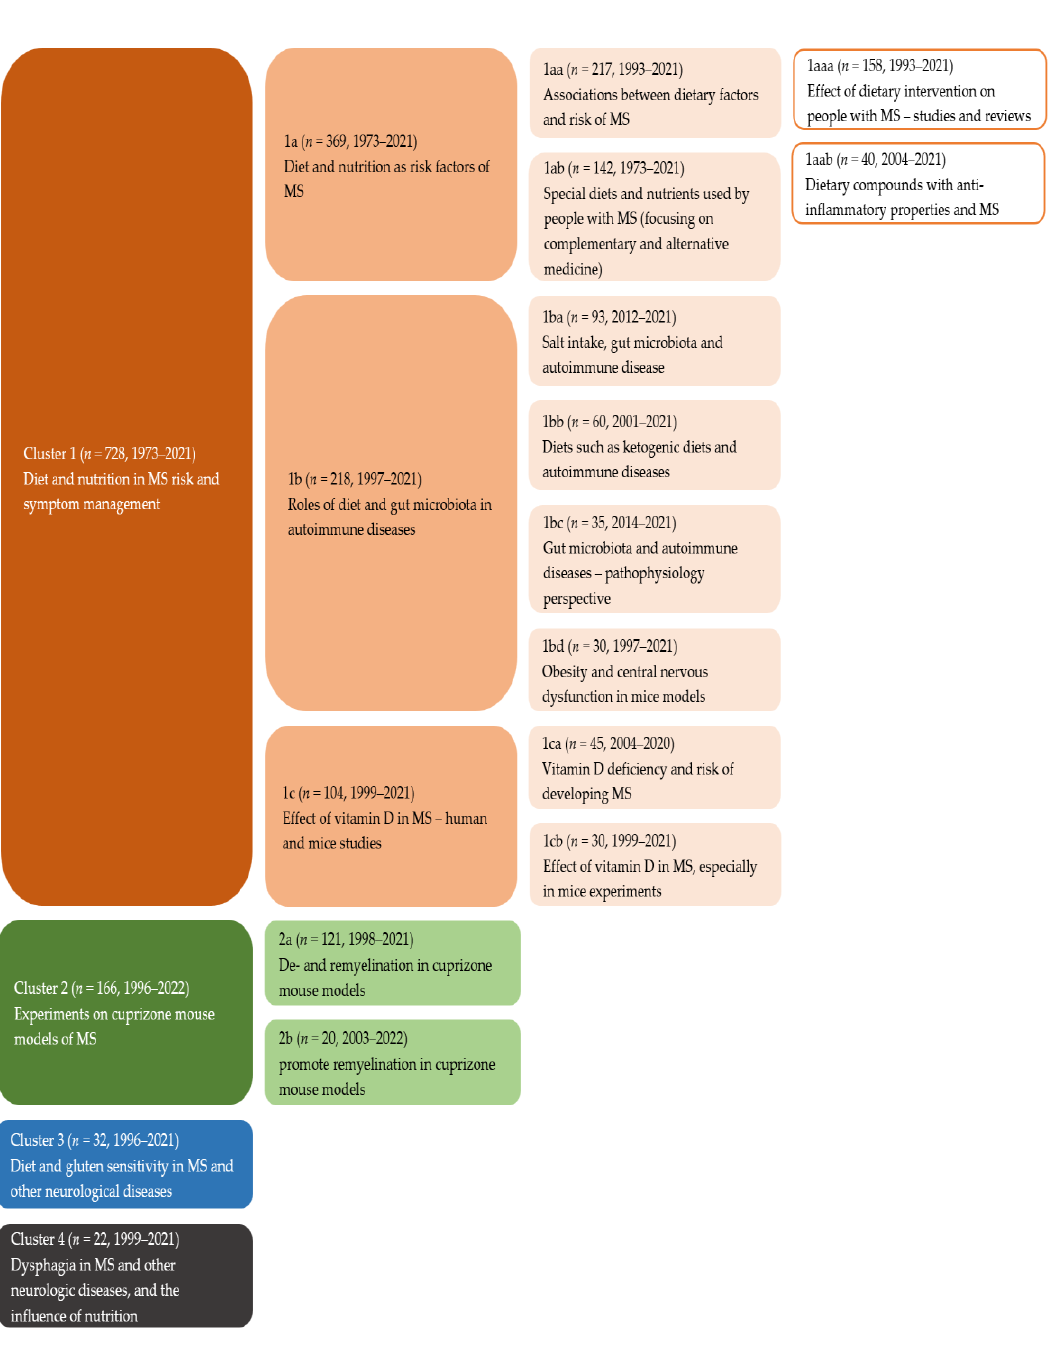
Figure 4. Literature map with topics of clusters and sub-clusters extracted by text mining. Each text box illustrates a cluster or sub-cluster of publications. Alphanumeric characters (1a, 1aa, 1aaa, 1aab, 1ab, 1b, 1ba, 1bb,1bc, 1bd, 1c, 1ca, 1cb, 2a, 2b) have been assigned to clarify the hierarchical relationship between sub-clusters. Orange, cluster 1; green, cluster 2; blue, cluster 3; and grey, cluster 4.